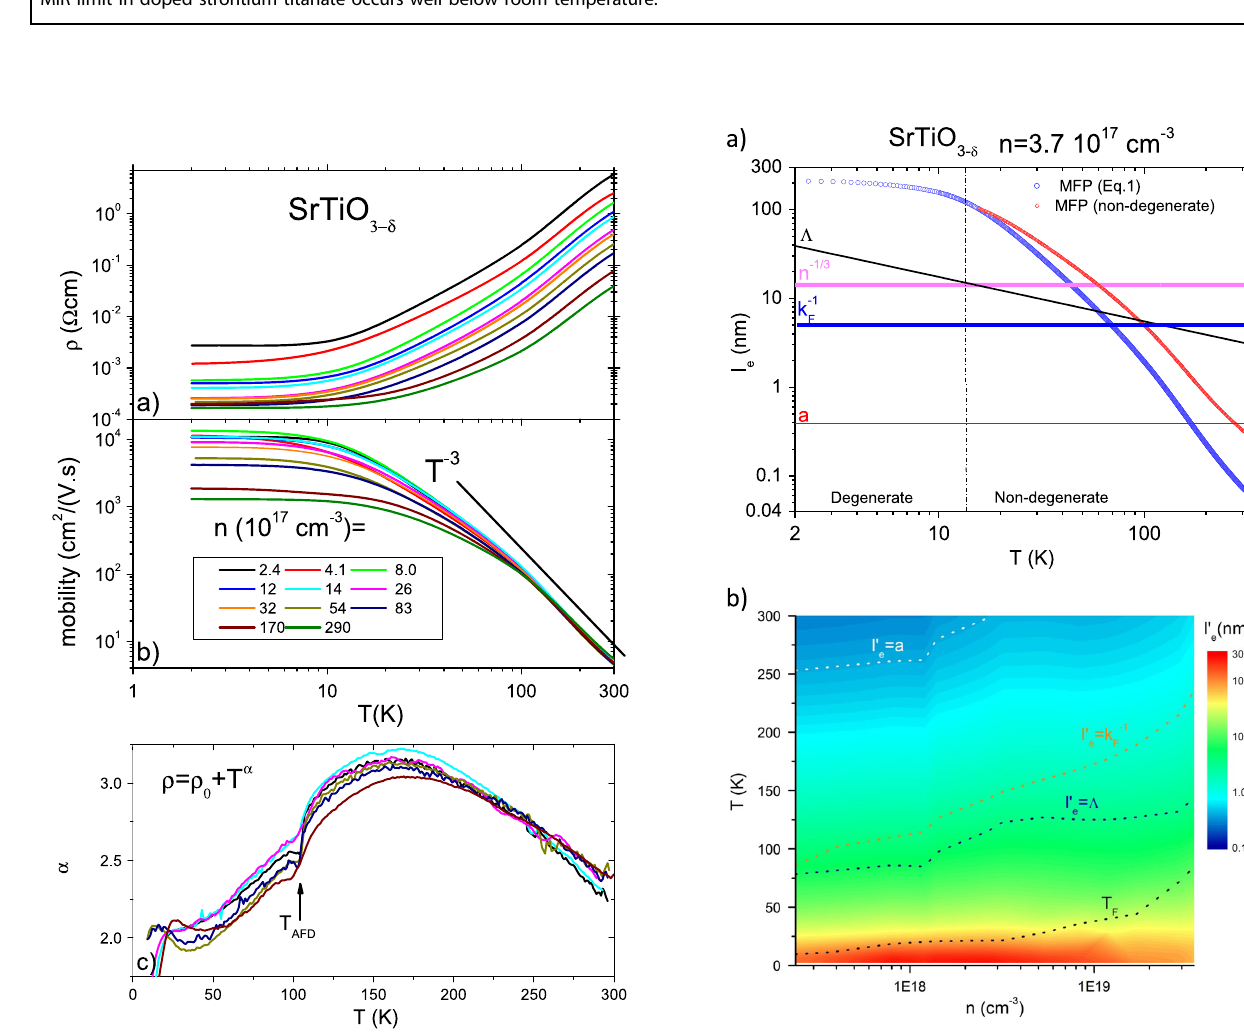
Fig. 2 Breakdown of the Mott-Ioffe-Regel limit. a Temperature dependence of the mean-free-path in dilute metallic SrTiO 3 − δ sample up to 400 K. Blue circles represent ‘ e , extracted from resistivity using Eq. (1). Red diamonds represent the mean-free-path ¼ ‘ n (cid:4) 1 = 3 in the non-degenerate regime: ‘ ′ e Λ . Also shown are the de e Broglie thermal wavelength, Λ , the inter-electron distance n − 1/3 , the inverse of the Fermi wavelength ( k (cid:4) 1 ) and the lattice parameter, a = F 0.39 nm. The system remains metallic even at 400 K, in spite of exceeding the MIR limit by all conceivable criteria. b A color , extracted from the resistivity data of Fig. 1 in the (T, n ) plot of ‘ ′ e plane. Different crossovers are shown. The MIR limit is exceeded in